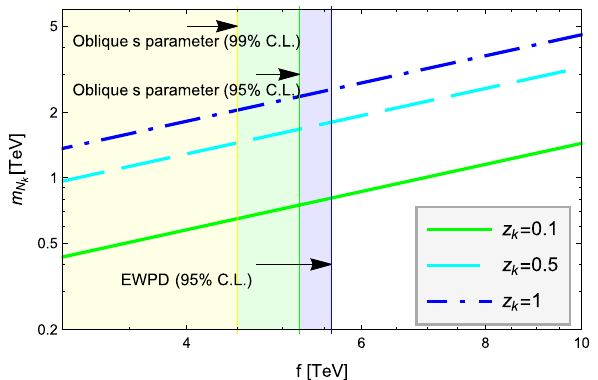
Fig. 5 Heavy neutrino mass as a function of f for t β = 9 and three / m ) 2 . The vertical lines represent the lower values of z k = ( m N X k bounds on f arising from several observables (see Table 1) Table 2 Values used in our Parameter numerical analysis for the parameters involved in the AMDM and AWMDM of the τ lepton